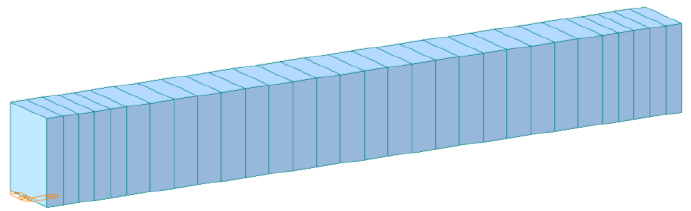
Figure 7. The testing beam model.